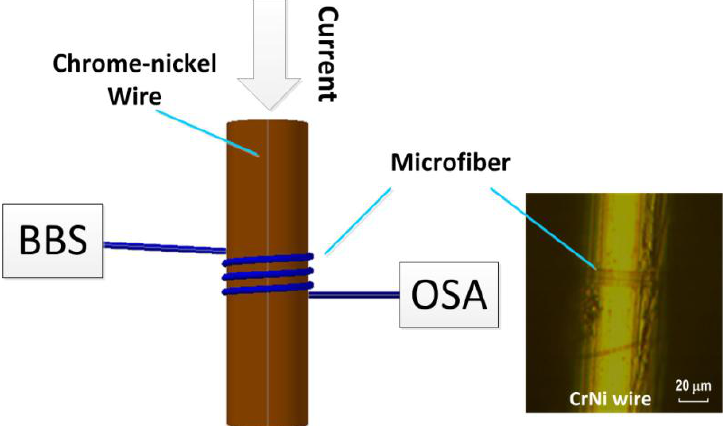
Figure 1. Schematic of our electric current sensor with a microfiber and a CrNi wire. Inset shows a micrograph of a fabricated structure.